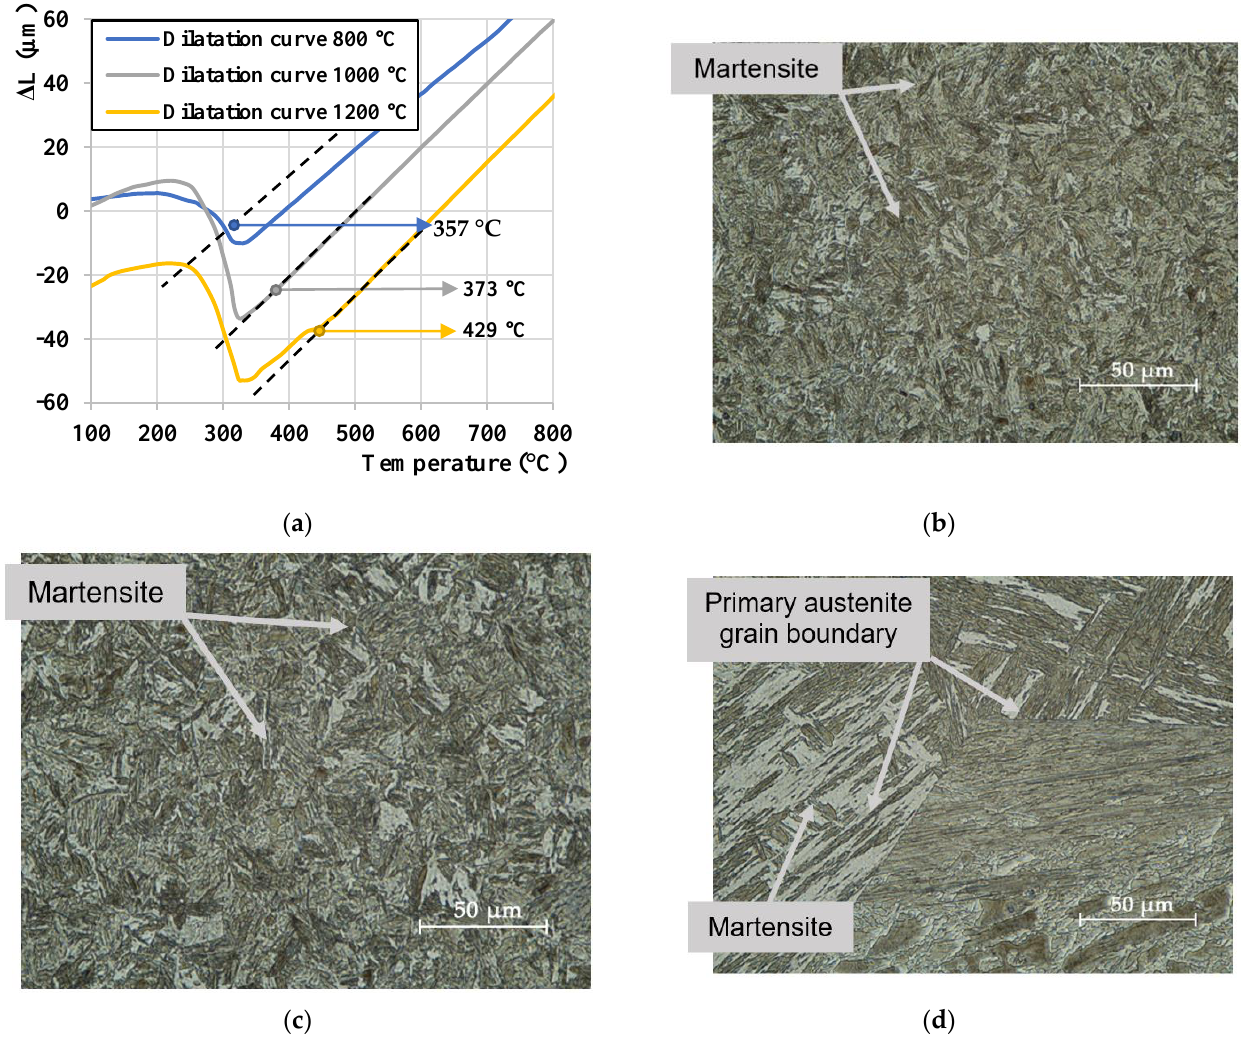
Figure 3. ( a ) Ms temperature for cooling mode from the austenitization temperature of 800 °C, 1000 °C, and 1200 °C obtained by dilatometry; LOM micrographs for the samples austenitized at ( b ) 800 °C; ( c ) 1000 °C; ( d ) 1200 °C.